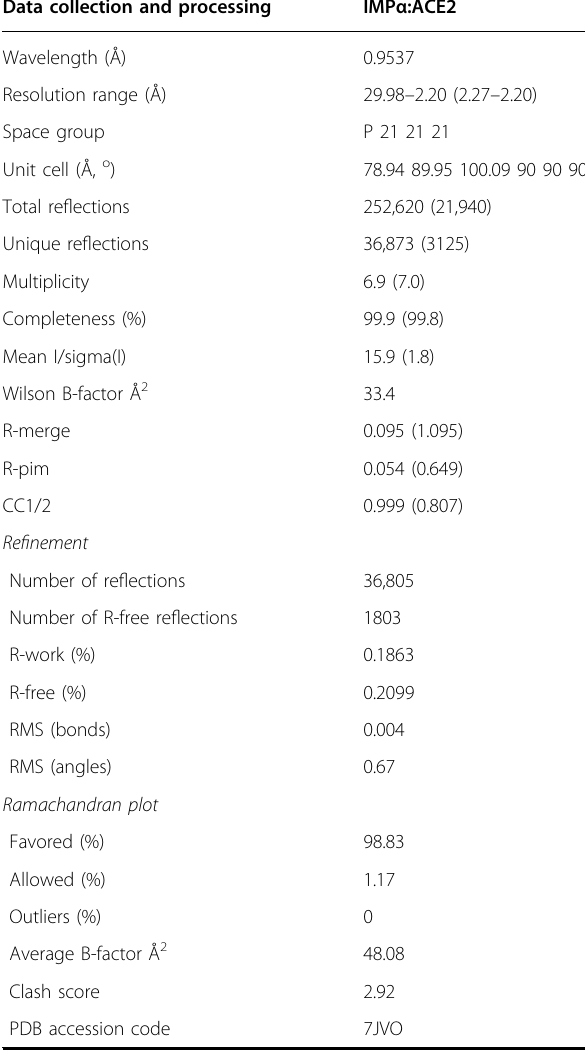
Table 1 Data collection and re fi nement